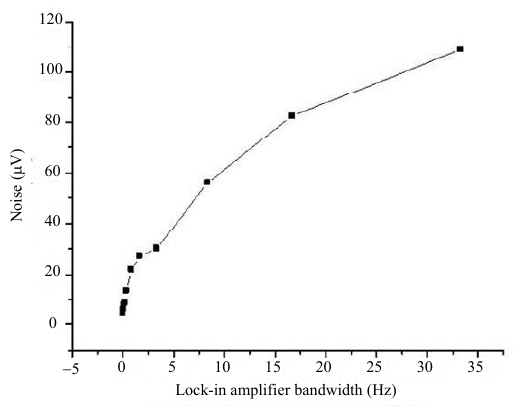
Fig. 6 Signal noise at different lock-in amplifier bandwidths.